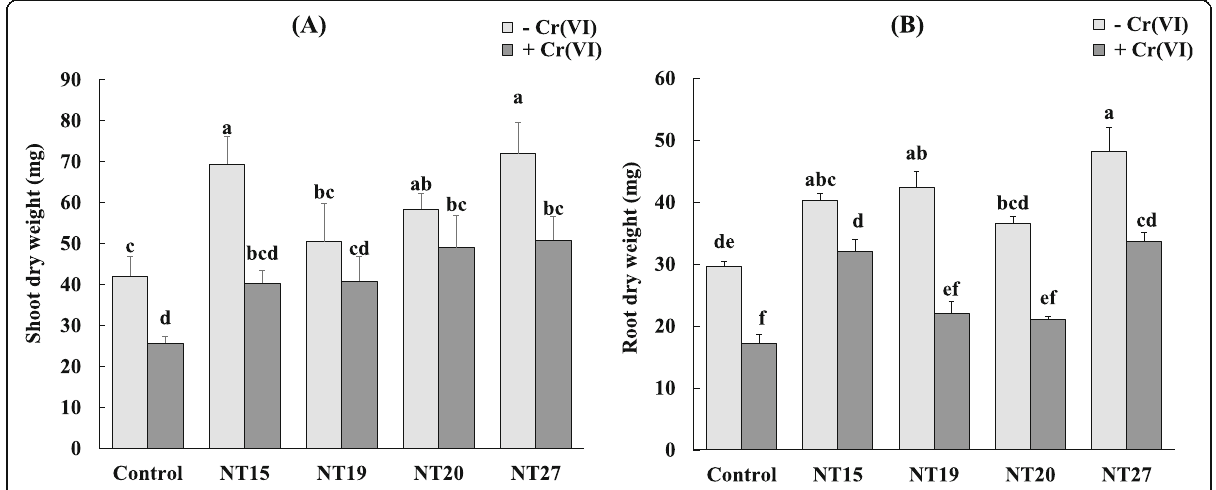
Fig. 1 Effect of inoculation with NT19, NT15, NT20, and NT27 on the dry weight of the shoot ( A ) and root ( B ) of M. sativa in the absence ( − Cr (VI)) and the presence of Cr (VI)(+ Cr(VI)). Values are means ± SE ; values with different letters are significantly different ( p < 0.05)